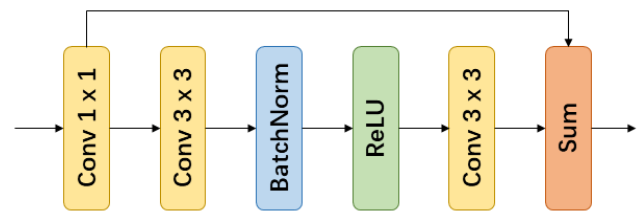
Figure 4. Residual Convolutional Module